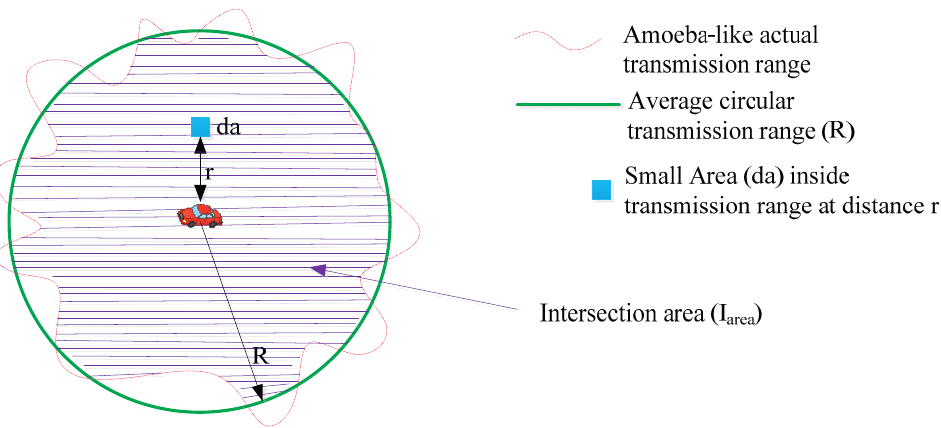
Figure 5. Non-circular transmission range shape due to